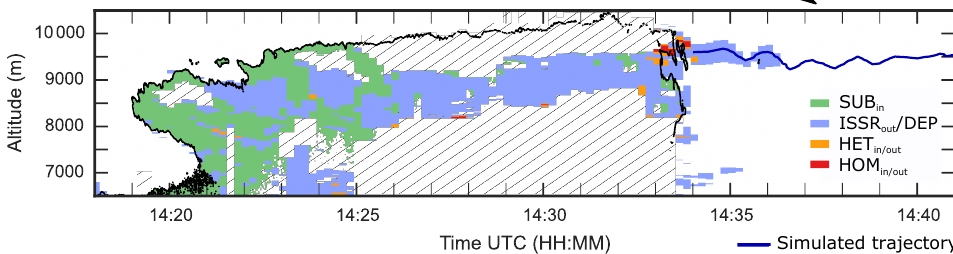
Figure 5. Classified evolution regions of cirrus cloud. In-cloud and cloud-free regions can be distinguished by the black contour line of BSR = 2. Regions of ice nucleation (HOM in / out , HET in / out ), ice supersaturation outside (ISSR out ), and depositional growth (DEP) and subsaturation (SUB) inside the cloud are visualized. Subsaturated regions outside the cloud are left blank and invalid data are marked by black hatching. The blue line shows a trajectory used for simulation of adiabatic cooling (see Sect. 4.3 and Fig. 7).